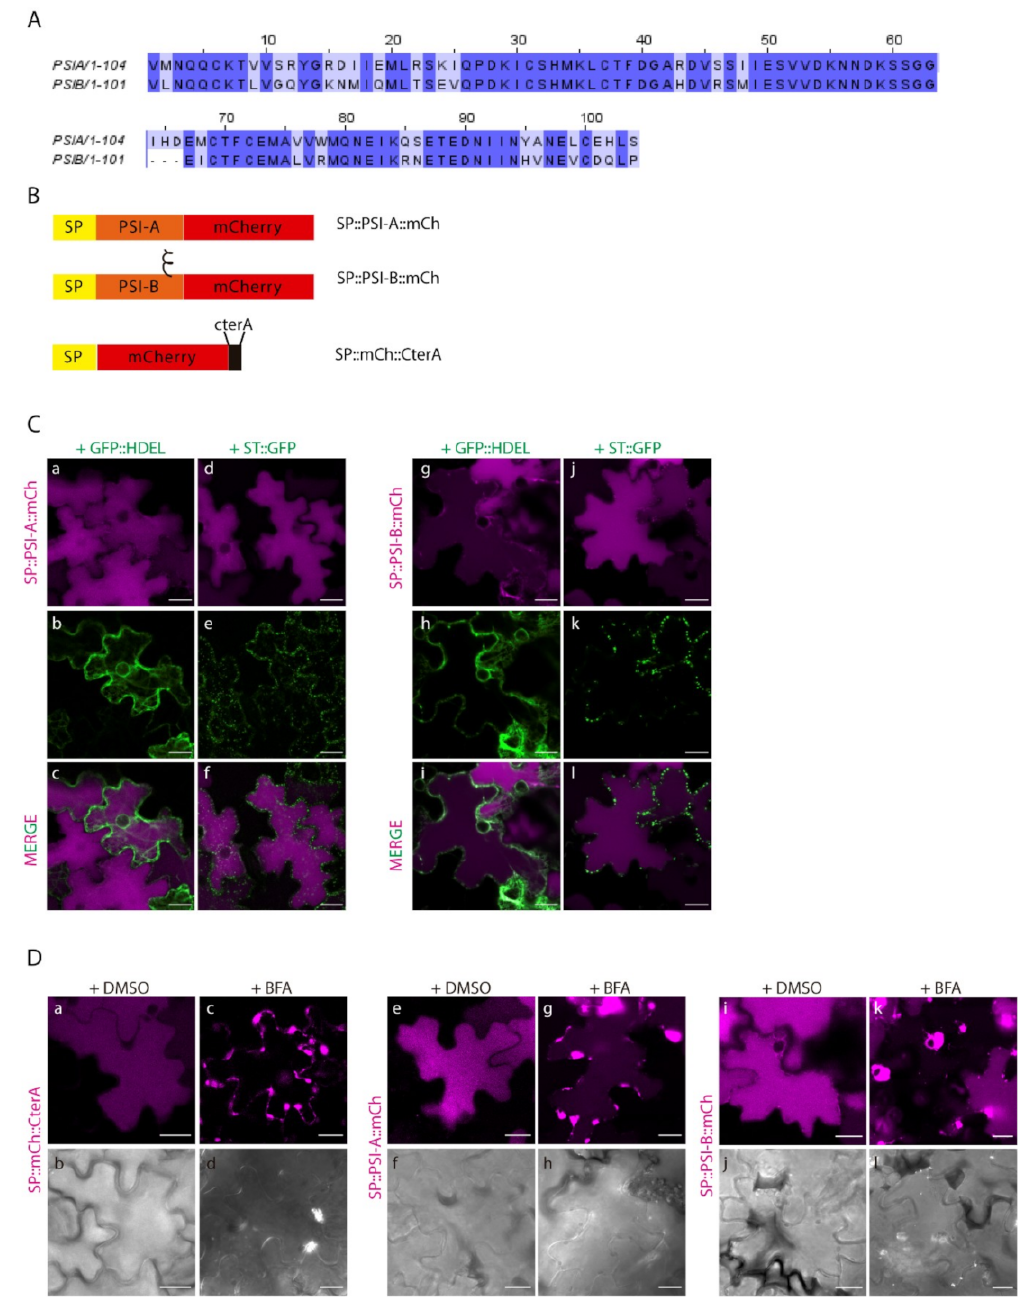
Figure 3. Expression of PSI-A and PSI-B in N. tabacum epidermal cells reveals subtle di ff erences between the two. ( A ) Alignment of cardosins’ A and B PSIs, showing the similarity between them. ( B ) Schematic representation of the fusion proteins designed for this study. ( C ) Co-expression of SP::PSI-A::mCh with the ER marker GFP::HDEL (a–c) and the Golgi marker ST::GFP (d–f) and of SP::PSI-B::mCh with GFP::HDEL (g–i) and ST::GFP (j–l). Single images for both channels and the composite image are provided. ( D ) Expression of PSI-A (e–h) and PSI-B (i–l) followed by Brefeldin A treatment. SP..mCh::CterA (a–d) was used as a positive control, and DMSO was used as a negative control for the experiment. DIC images of the same cells were also acquired to evaluate the cell morphology. All observations and images were acquired 3 days post-infiltration. Images were analyzed and processed using ImageJ / Fiji software. Scale bars: ( C ) and ( D )—20 µ